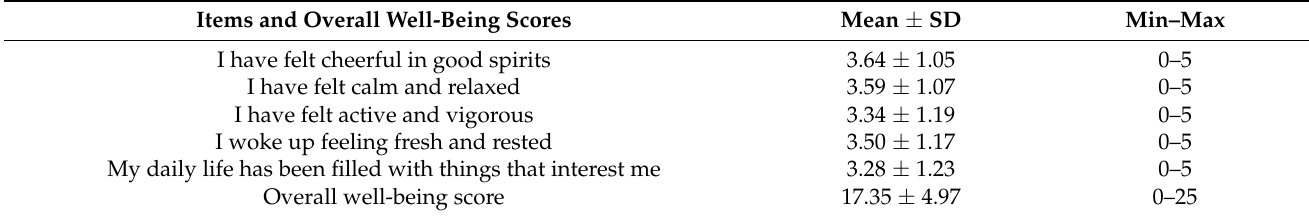
Table 7. The mean scores of each item of the WHO-5 well-being scale, and the overall well-being score ( n = 1922). Items and Overall Well-Being